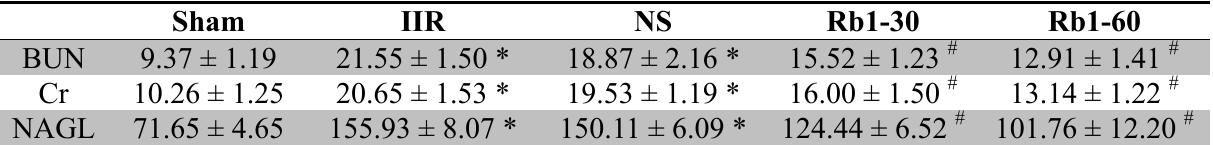
Table 1. Changes of serum BUN (mmol/L), Cr ( μ mol/L) and NGAL (ng/ml) levels.